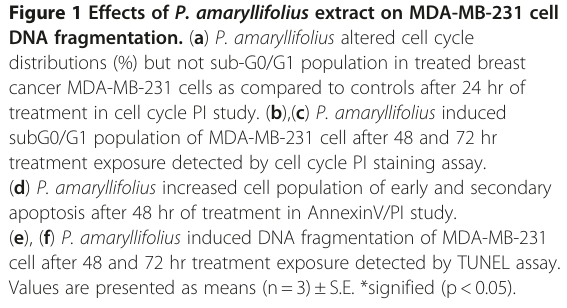
Figure 1 Effects of P. amaryllifolius extract on MDA-MB-231 cell DNA fragmentation. ( a ) P. amaryllifolius altered cell cycle distributions (%) but not sub-G0/G1 population in treated breast cancer MDA-MB-231 cells as compared to controls after 24 hr of treatment in cell cycle PI study. ( b ),( c ) P. amaryllifolius induced subG0/G1 population of MDA-MB-231 cell after 48 and 72 hr treatment exposure detected by cell cycle PI staining